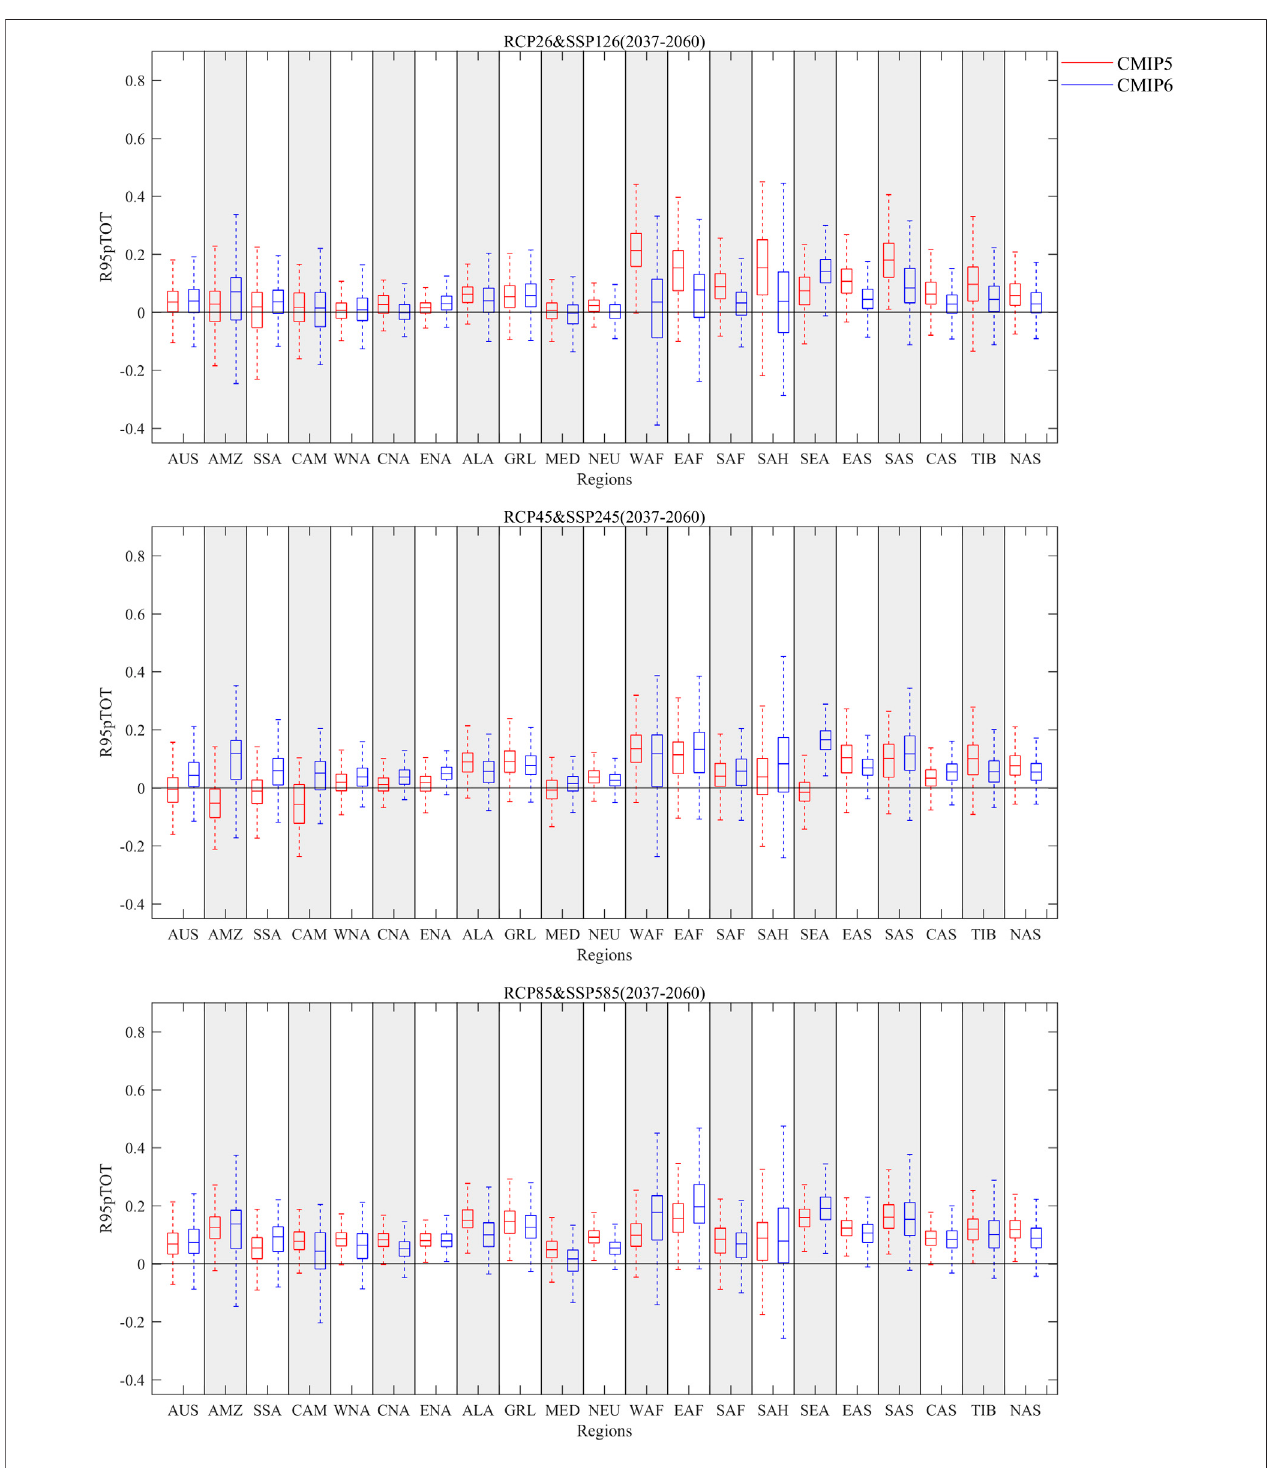
FIGURE 9 | Box plots for R95pTOT multi-model mean changing rates in 21 regions in near-future period (2028 – 2060) over the historical period (1982 – 2005) in CMIP5 and CMIP6. CMIP5 is presented in red and CMIP6 is presented in blue.